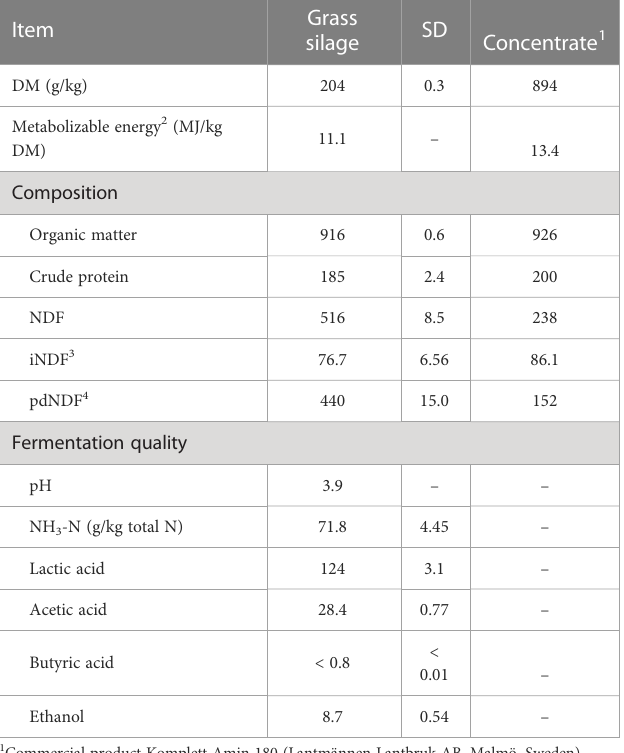
Grass SD silage